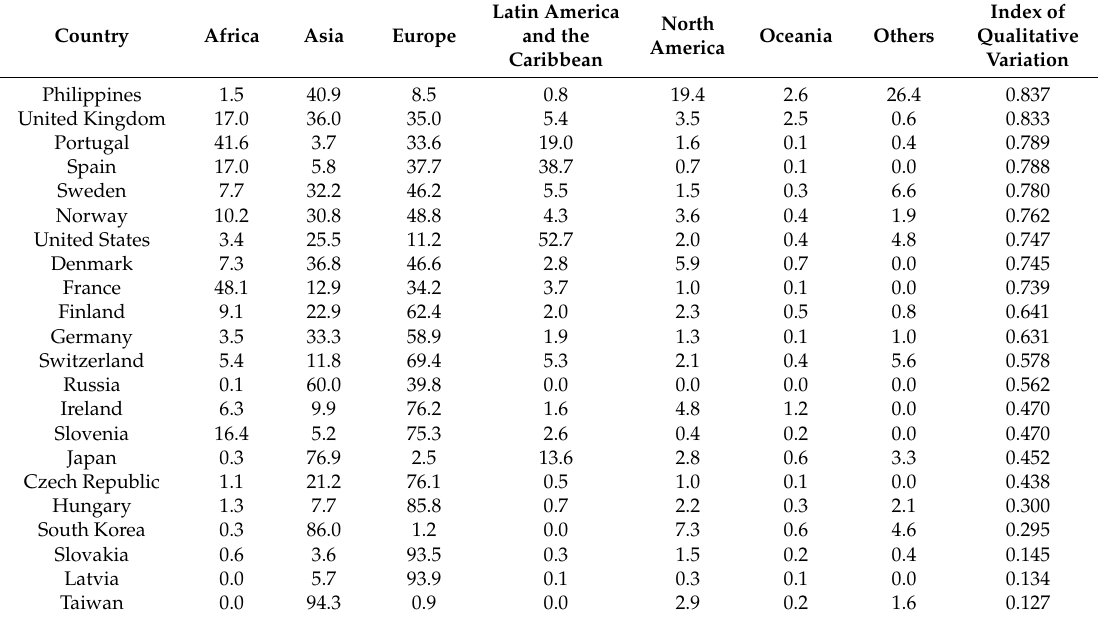
Table 8. Percentage of immigrants by area of origin and index of qualitative variation, 2010. Country Africa Asia Europe